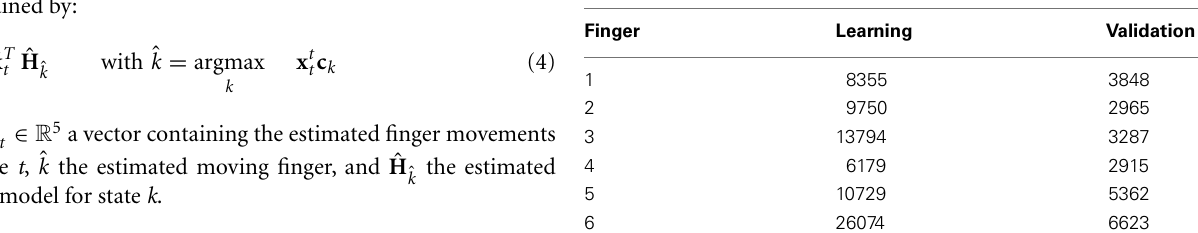
Table 1 | Number of samples used in the validation step for subject